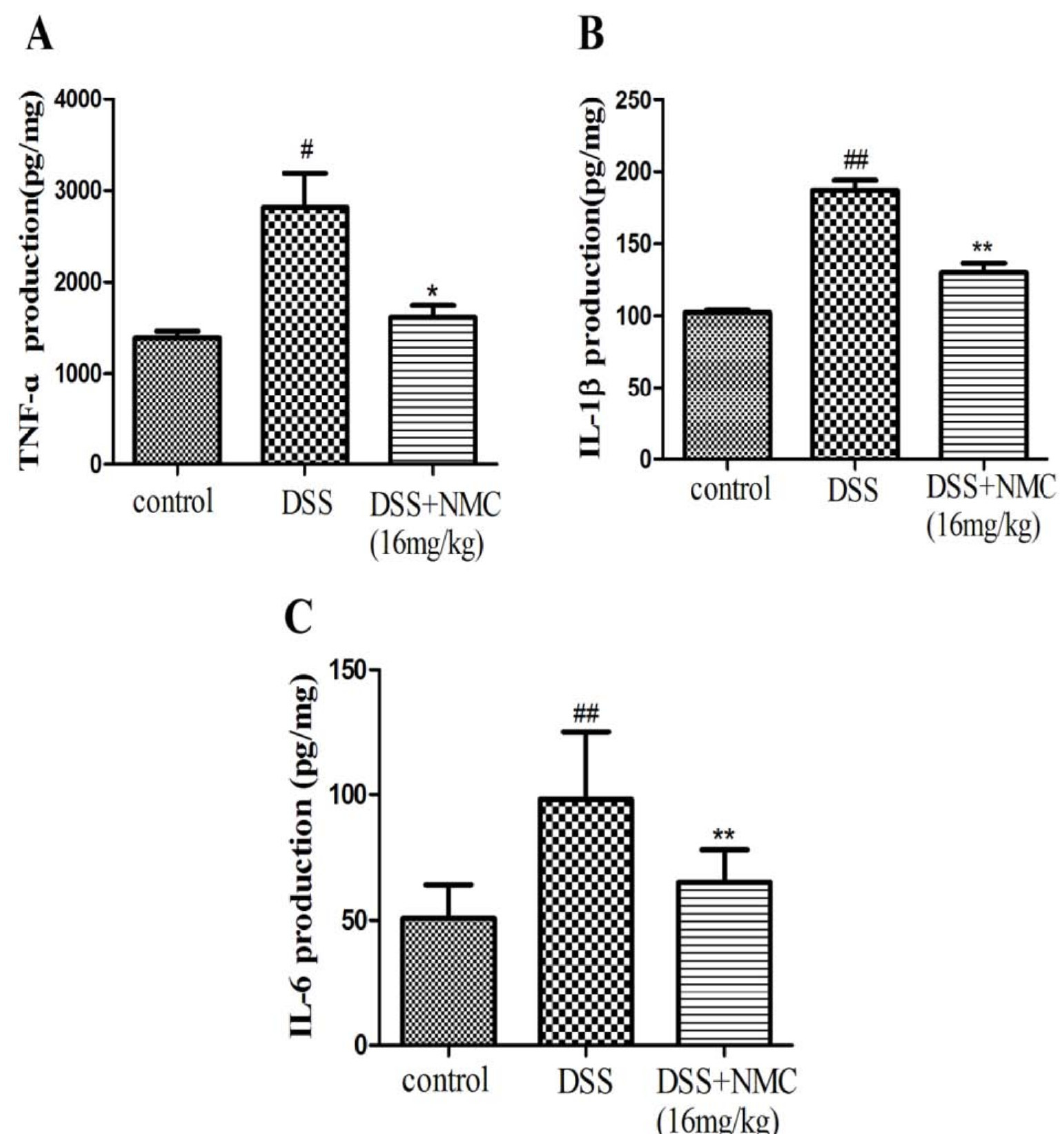
Figure 5. Effects of NMC on levels of TNF- α , IL-6 and IL-1 β of colon in DSS-induced colitis using ELISA. ( A ) TNF- α , ( B ) IL-1 β , ( C ) IL-6. Data are expressed as mean ( n = 10 per group) ± SEM. # p < 0.5, ## p < 0.01 compared with control group; * p < 0.05, ** p < 0.01 compared with the DSS-vehicle group.